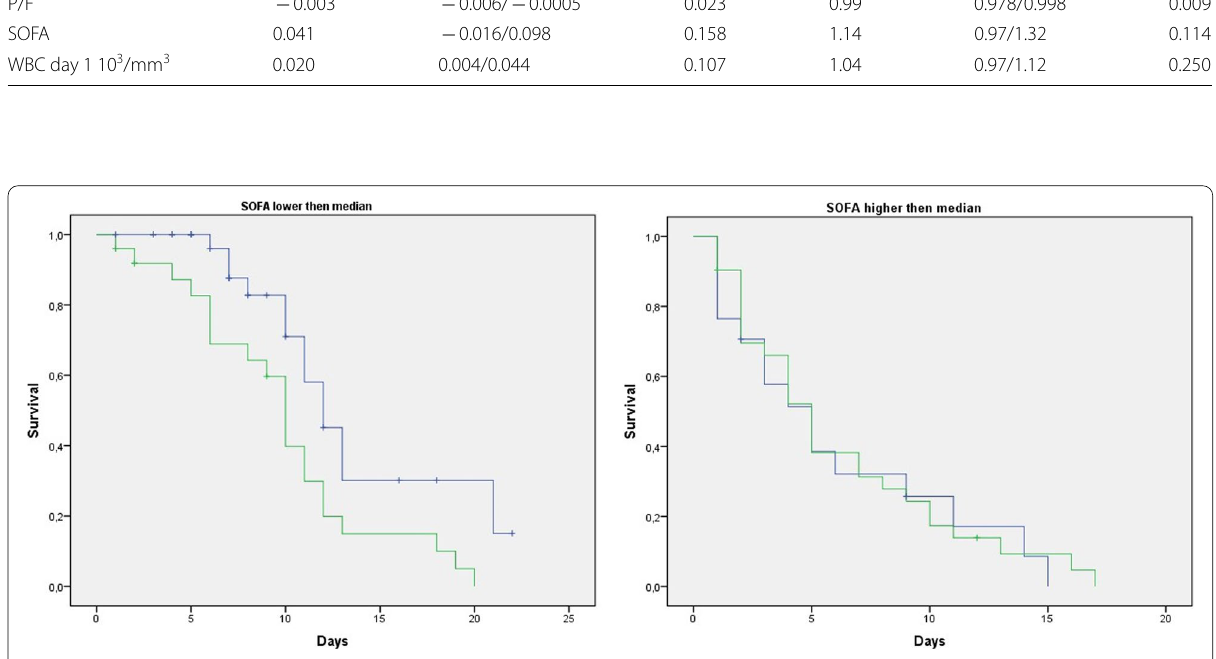
Fig. 3 Kaplan–Meier curves, dashed blue line represents group A; the solid green line represents group B. Upper panel, A and B group patients with SOFA value at admission lower than median SOFA; lower panel, A and B group patients with SOFA value at admission higher than median (SOFA median value 5). Upper panel, higher cumulative probability of survival on group A compared to group B when SOFA was < 5. Lower panel, similar = cumulative probability of survival in both groups (median 6 vs 5 days in group A and group B, respectively). KL-6 was a solid prognostic marker when SOFA lower than 5, while when SOFA was higher than 5, in the most severe patients, its prognostic power was not statistically